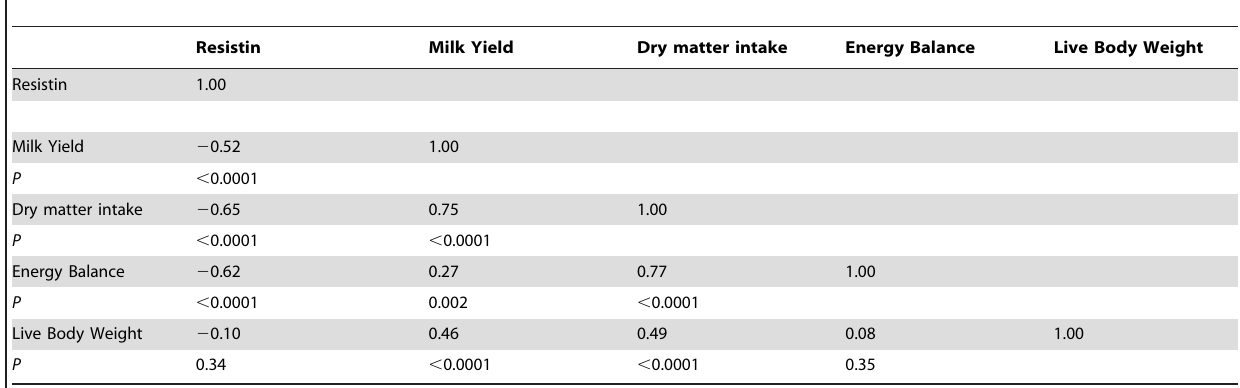
Table 5. Statistical analysis of the relationships between quantitative parameters (resistin plasma levels, milk yield, dry matter intake and energy balance during the period 1 to 20 WPP) using Pearson correlations with the CORR procedure of the SAS software.